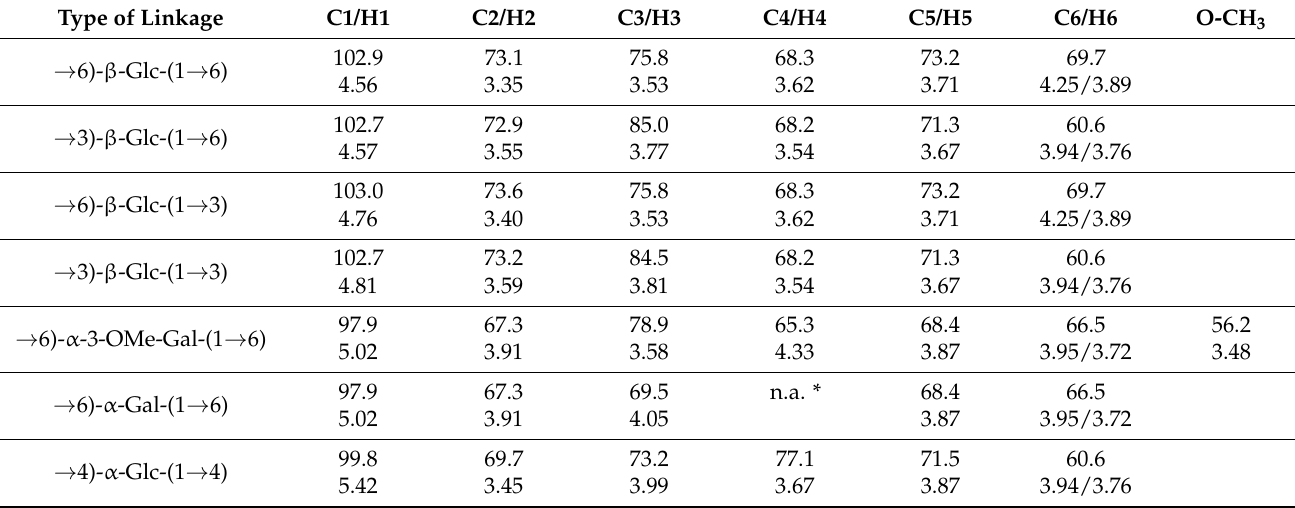
Table 2. 13 C and 1 H chemical shifts (ppm) for the polysaccharides extracted from I. obliquus mycelium. Type of